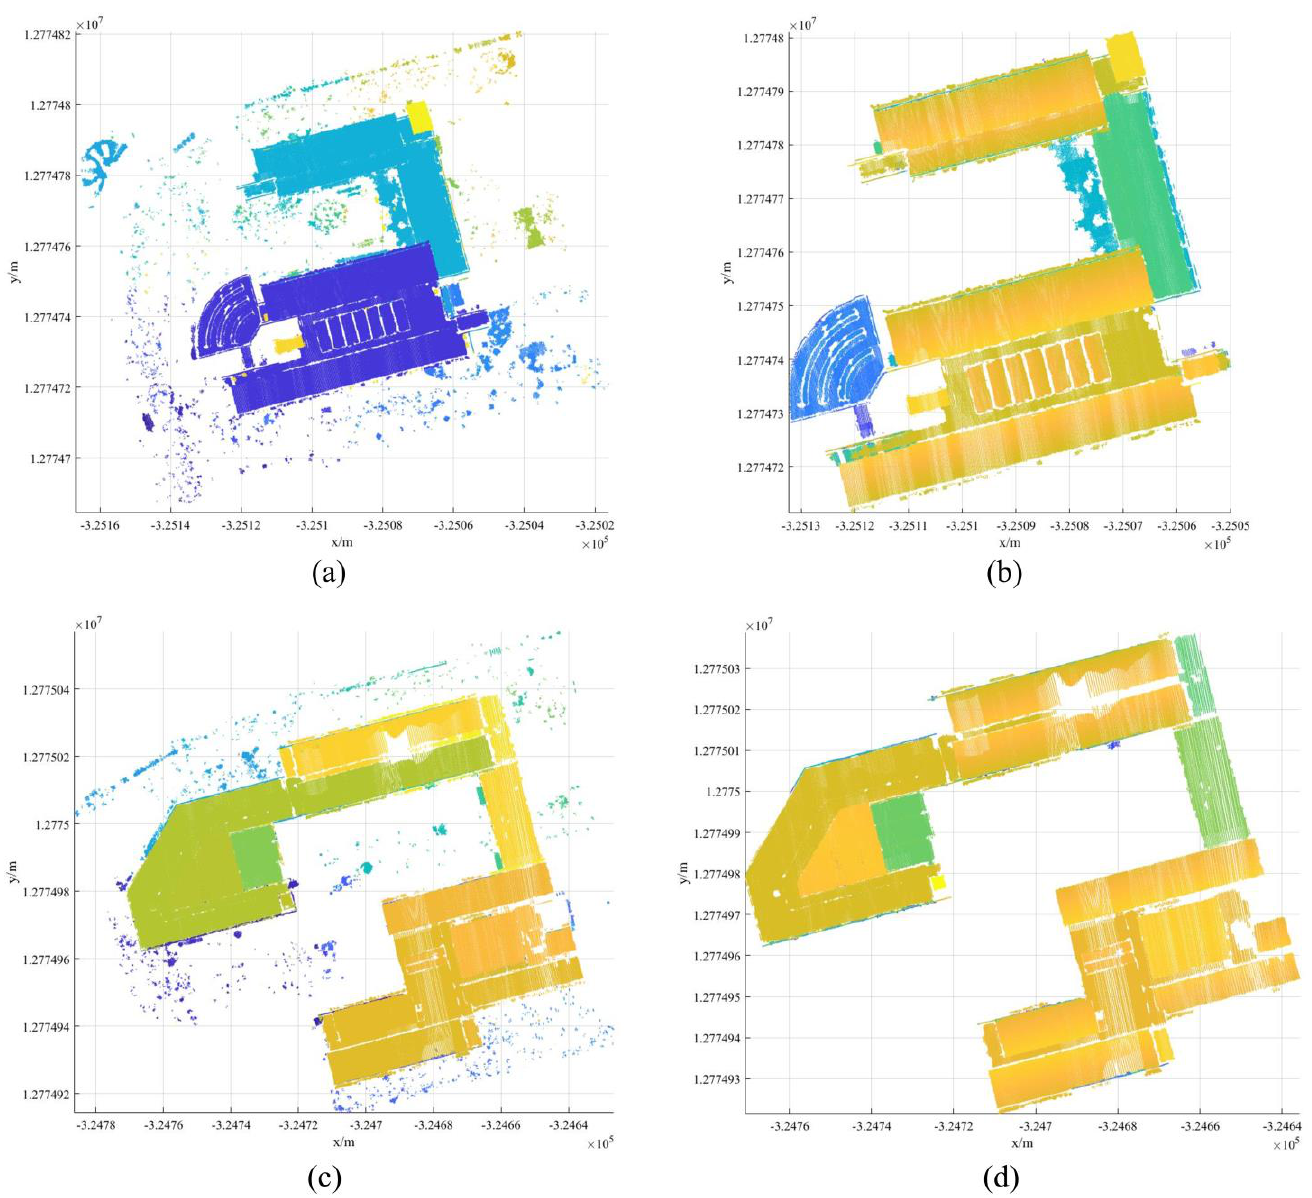
Figure 9. Accurate extraction results of the building point cloud. ( a ) Cluster result of plot 1; ( b ) Building extraction result of plot 1; ( c ) Cluster result of plot 2; ( d ) Building extraction result of plot 2.